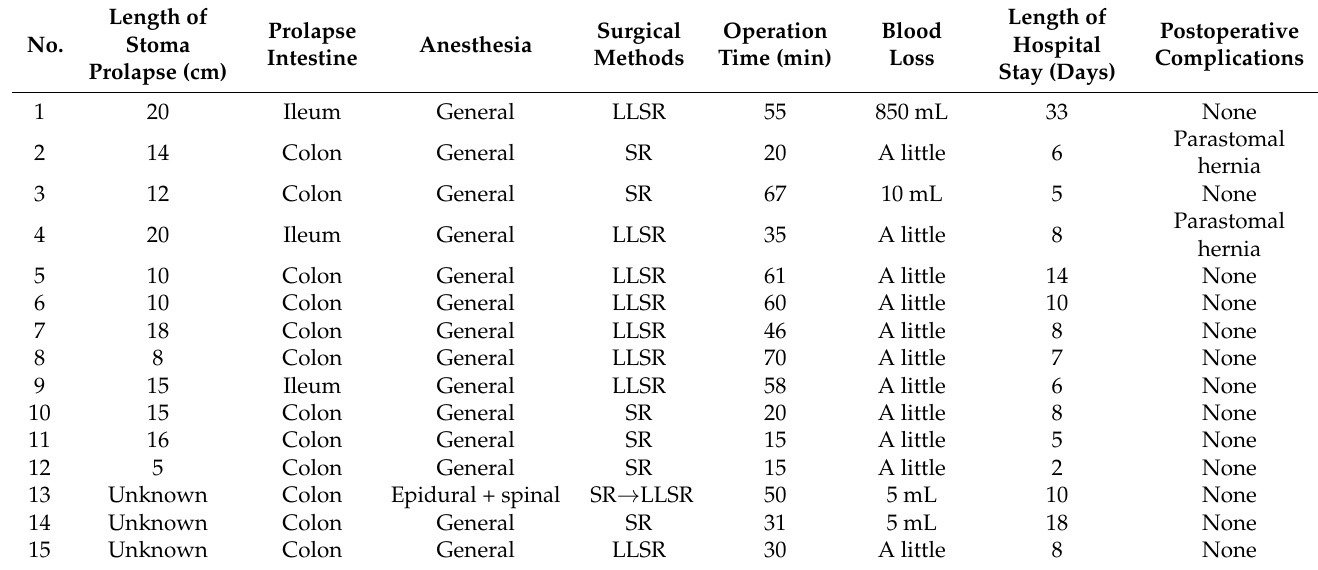
Table 2. The surgical results for each case.